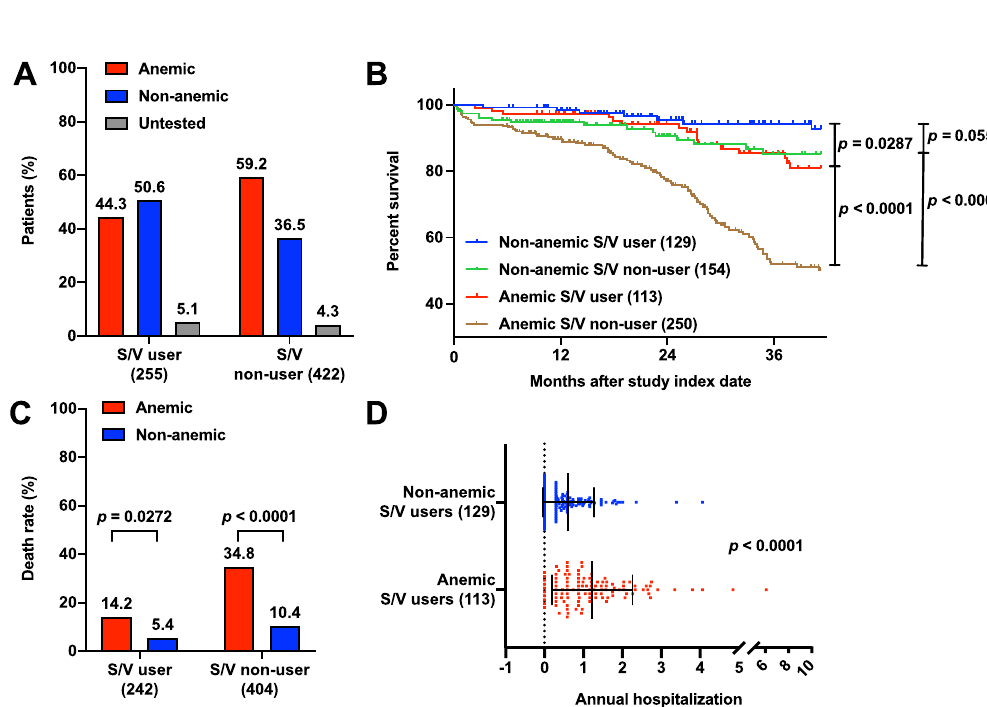
Figure 3. Effects of anemia among patients undergoing and not undergoing S/V treatment. We identified patients receiving S/V from the study cohort and investigated the effects of anemia in this population. ( A ) Among the S/V-using patients, the prevalence of anemia was 44.3%. ( B ) The Kaplan–Meier survival curves and log-rank tests indicated that the S/V-using patients who had anemia had significantly lower survival rates than did those without anemia. The patients with anemia who were receiving S/V also had significantly higher survival rates than did those who did not receive S/V. ( C ) Mortality was higher among patients with anemia than among those without anemia regardless of S/V therapy. ( D ) The S/V-using patients who had anemia had a significantly higher annual number of all-cause hospitalizations than did those without anemia. S/V: sacubitril–